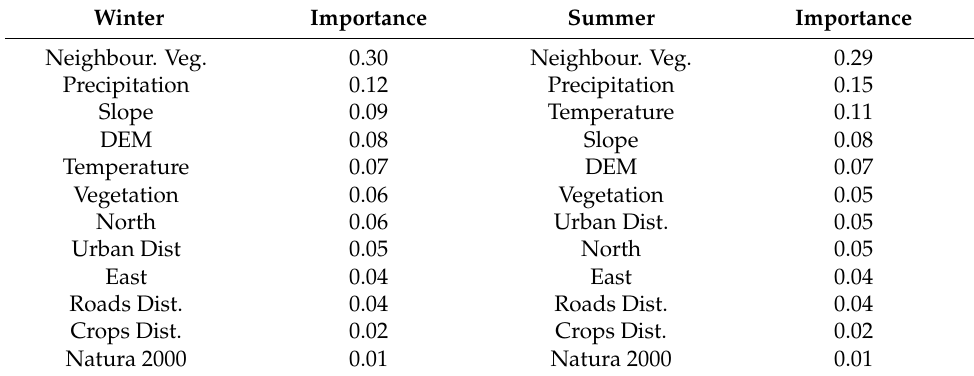
Table 4. Impurity-based importance measures for the Winter (left) and Summer (right) wildfire season